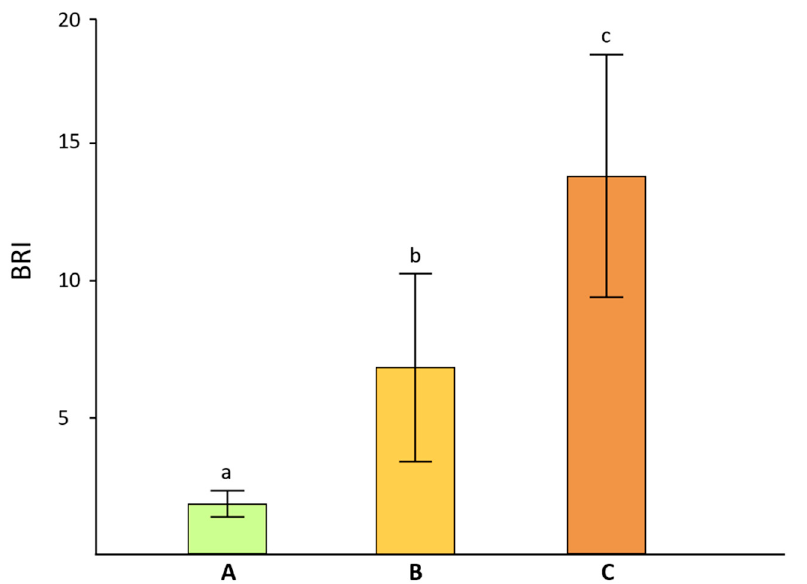
Figure 2. Browning reflectance index of non-melanized ( A ), weakly melanized ( B ) and strongly melanized ( C ) lichen thalli. Columns with different letters on top differ significantly ( p < 0.05).